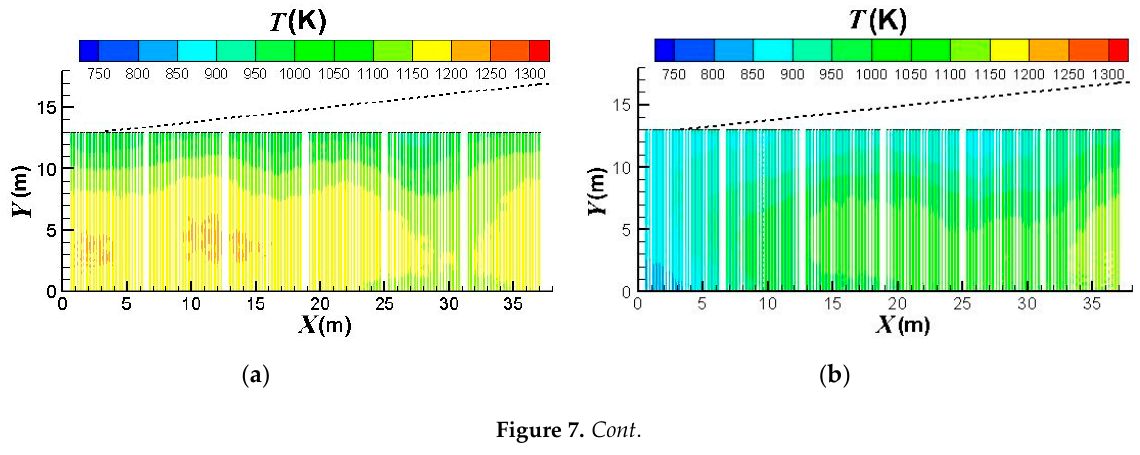
Figure 6. Outer surface average temperatures of the catalyst tubes using different burners on/off